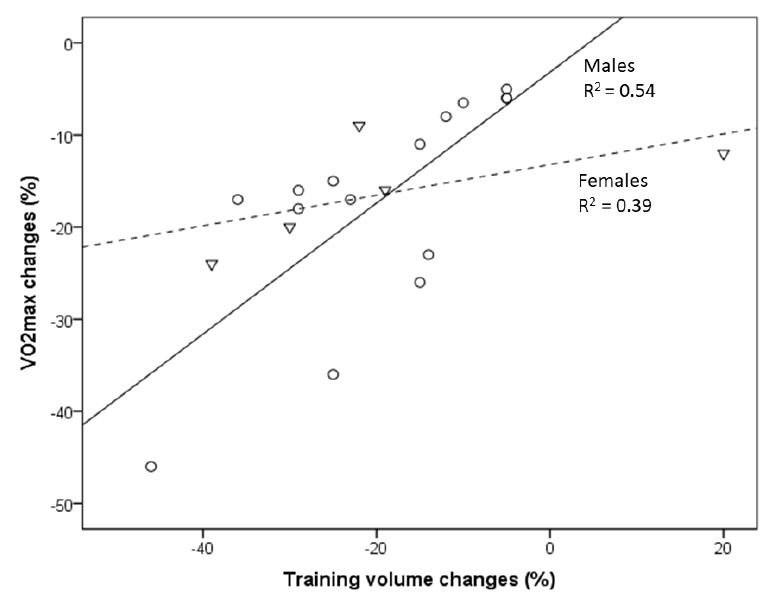
Figure 1. Relationship between VO 2 max decline and the reduction in training volume with aging of masters athletes (from data presented in Table 1) [16–21]. Circles indicate males, and triangles indicate females. Changes in the training volume explain 54% and 39% of the variance in VO 2 max changes in male and female masters athletes, respectively. Table 2. Effects of short-term (up to 12 weeks) training cessation and training (re)uptake on VO 2 max and related changes of physiological parameters (cardiorespiratory parameters are maximal